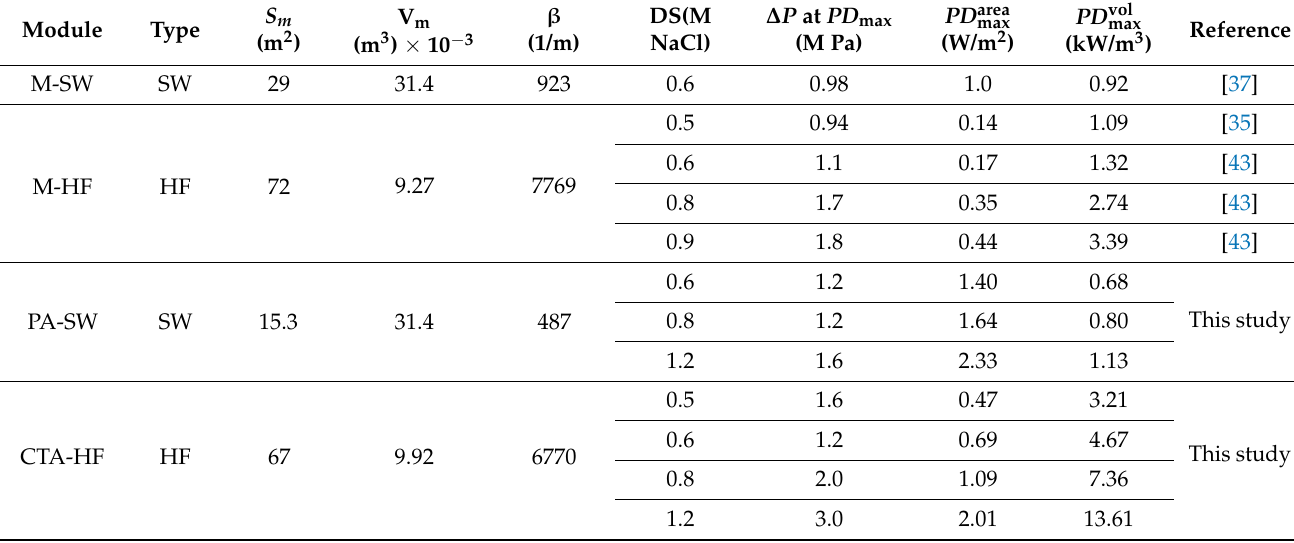
Table 2. Comparison between the dimensions and power densities of PRO modules from the literature and the current study. Module Type